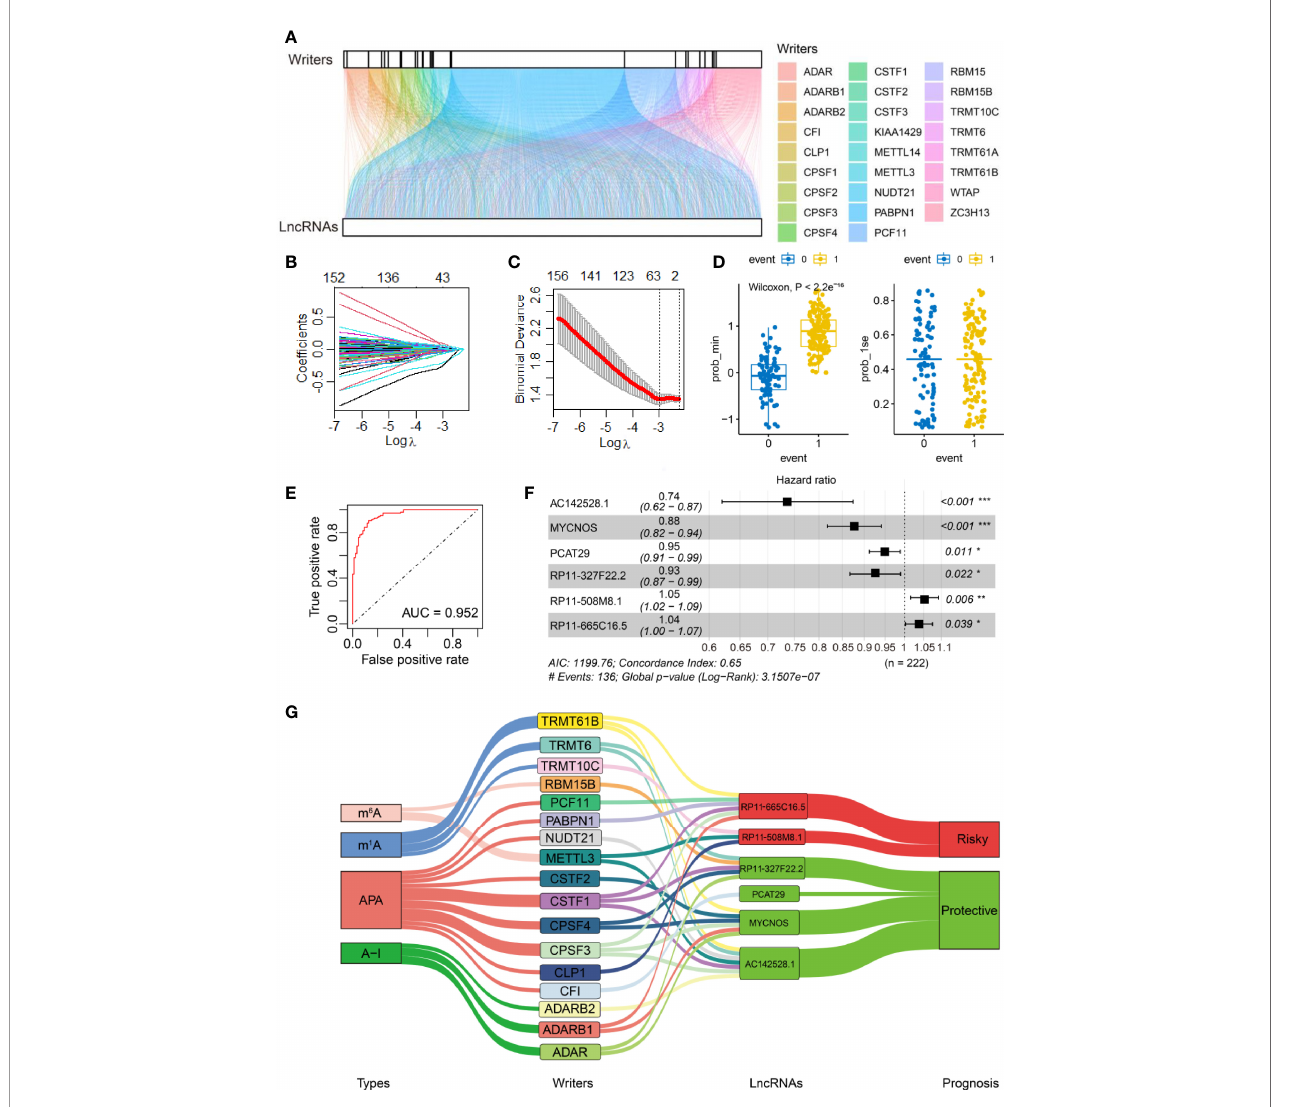
FIGURE 1 | Identi fi cation of RNA adenosine modi fi cation writer-related lncRNAs and establishment of the lncRNA-based risk model. (A) Alluvial diagram for 26 writer genes and writer-related lncRNAs. (B) The LASSO coef fi cient pro fi le of OS-related lncRNAs was drawn via 10-fold cross-validation. (C) The tuning parameters (log l ) of OS-related proteins were selected to cross-verify the error curve. Of the two dotted lines in the fi gure, the left is l Min, and the right is l 1se. l Min is the value of l that gives the minimum mean cross-validated error, whereas the other l saved is l 1se, which gives the most regularized model such that error is within one standard error of the minimum. (D) Self-prediction based on the minimal criterion and 1se criterion (0 and 1 represent the states where events are predicted to occur and not to occur, respectively, according to the model). (E) ROC curves of the model via internal validation. (F) Multivariate Cox regression analysis yielded six independent prognostic lncRNAs. PR11-508M8.1 and PR11-665C16.5 were risk factors, and the other four lncRNAs were protective factors for SOC. *P <0.05, **P <0.01, *** P < 0.001. (G) Relational Sankey diagram for signi fi cant correlations between 17 writer genes and six prognostic writer-related